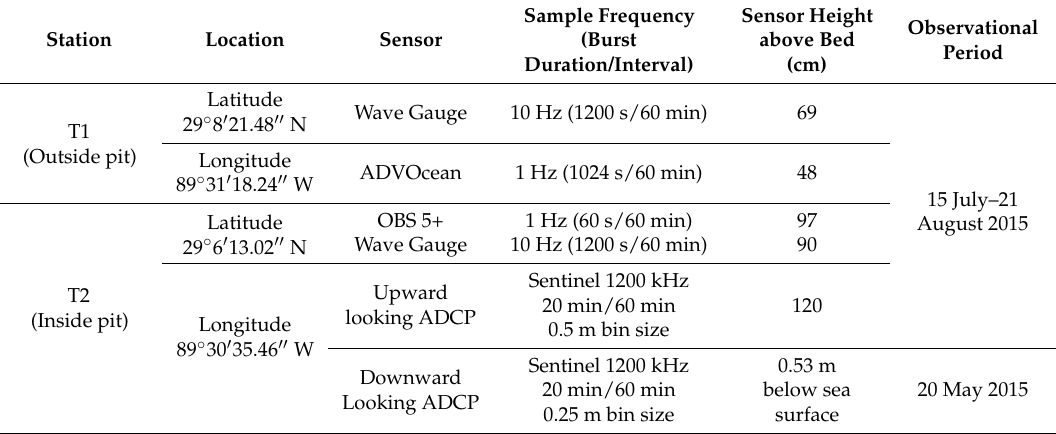
Table 1. Sensor sampling parameters and observational